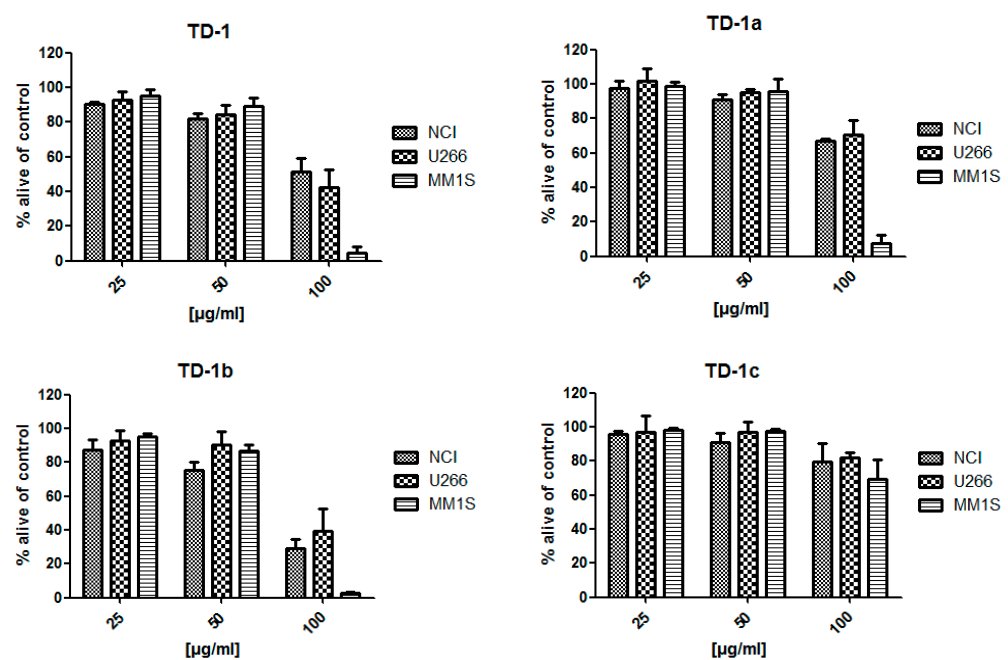
Figure 3. Viability of MM cell lines after treatment with fractions TD-1, TD-1a, TD-1b, and TD-1c. Three concentration levels (25, 50, 100 µg/mL) and 24 h incubation times are shown.